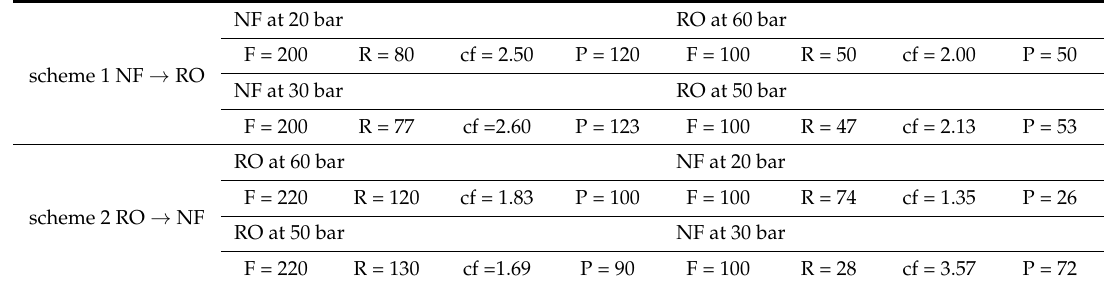
Table 3. Summary of experiments.